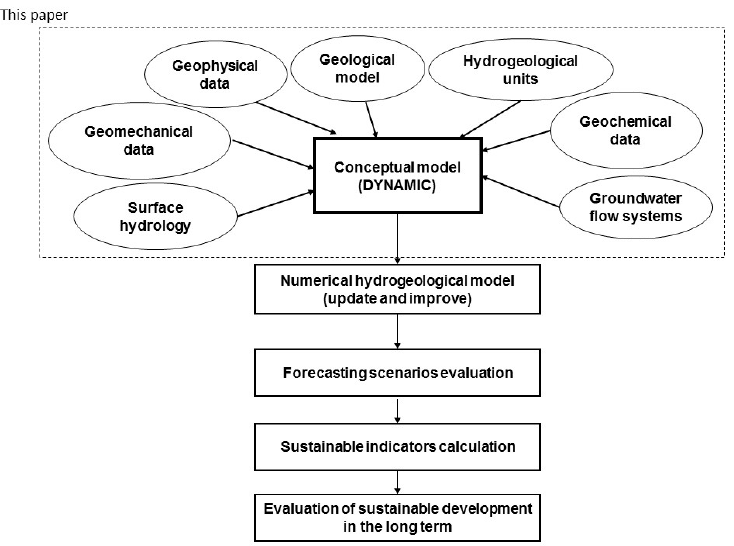
Figure 1. Successive stages for a sustainable evaluation of the Mexico Basin Aquifer in the long term; the dashed box shows the components of this study.